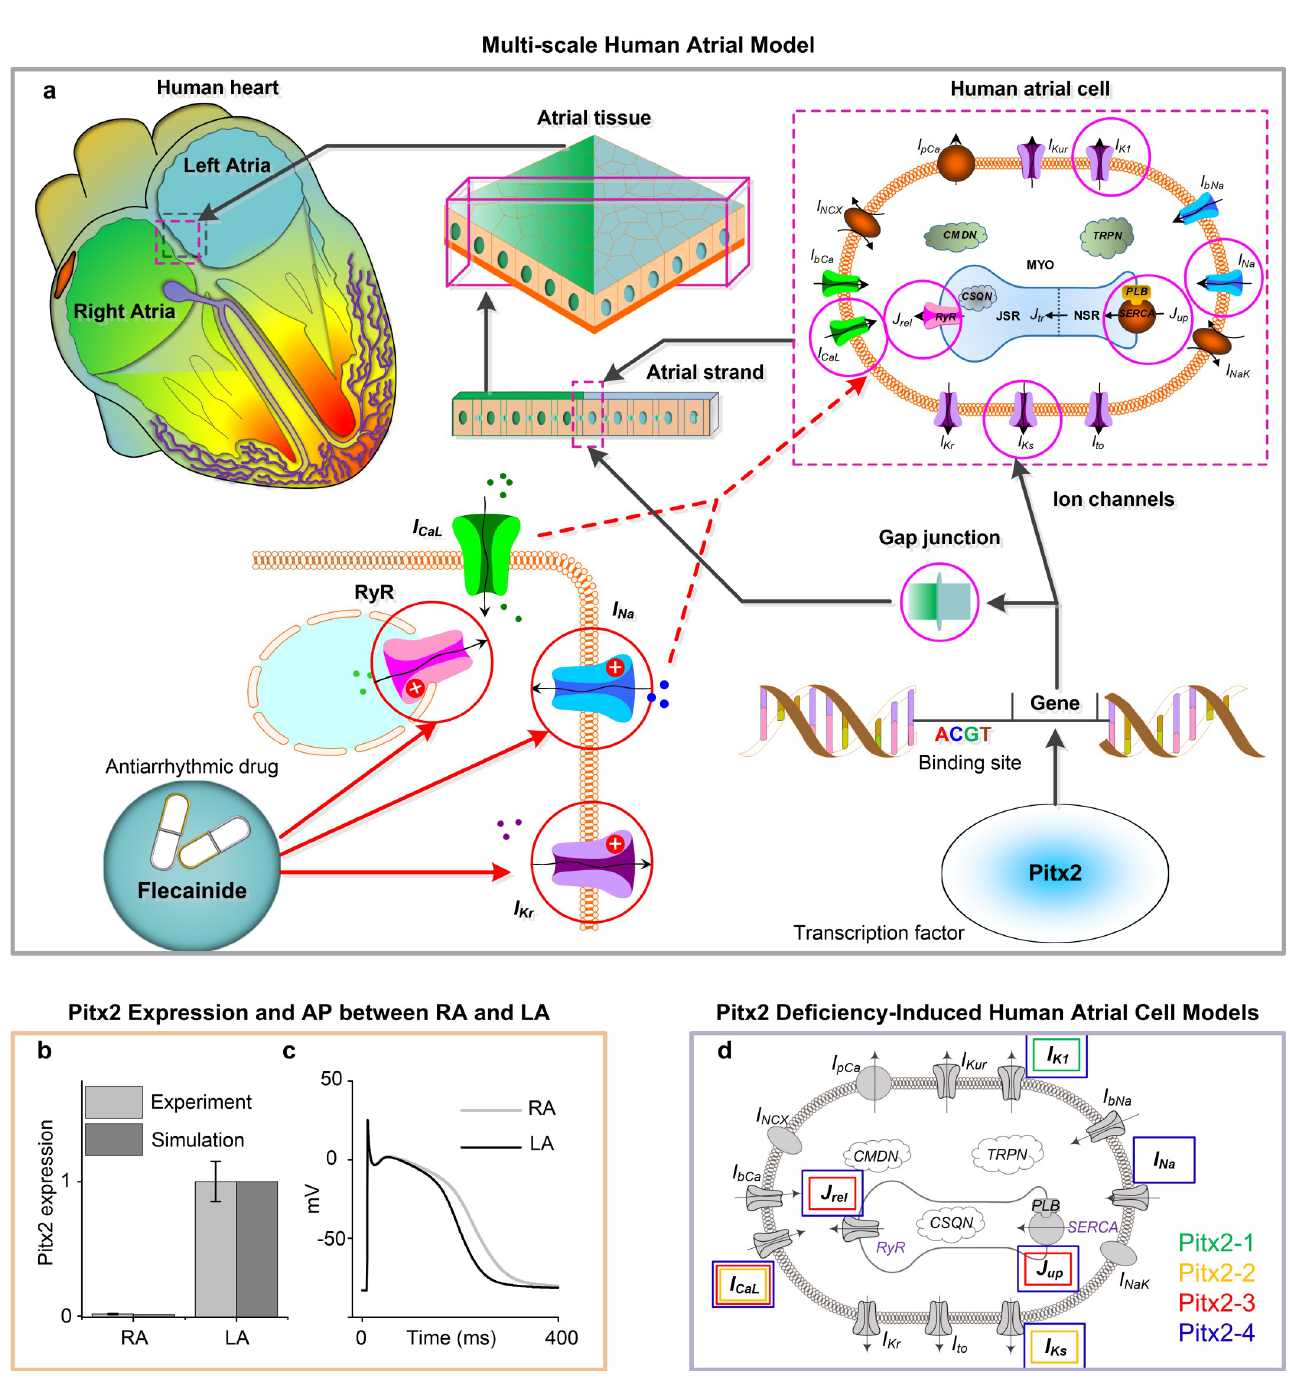
Fig 1. Multi-scale computer models to investigate the mechanism underlying Pitx2-induced AF and the effects of class Ic AAD (flecainide). a , The computer models incorporated Pitx2-induced electrical and structural remodeling, and flecainide interactions with ion channels. Remodeled targets (magenta circles) included gap junction, I K1 , I Ks , I Na , I CaL , RyR and SERCA. Drug targets of flecainide (red circles) were I Kr , I Na and RyR. Under the control condition, heterogeneity in Pitx2 expressions ( b ) and AP ( c ) between LA and RA was included in the computer models. d , Based on experimental and clinical studies up to date, four Pitx2 deficiency-induced human atrial cell models were developed: Pitx2-1 with remodeled I K1 (green), Pitx2-2 with remodelled I Ks and I CaL (magenta), Pitx2-3 with remodelled I CaL , RyR and SERCA (red) and Pitx2-4 with remodelled I K1 , I Ks , I Na , I CaL , RyR and SERCA (blue). Abbreviations: AF–atrial fibrillation; AAD–antiarrhythmic drug; LA–left atrium; RA–right atrium; AP–action potential; RyR–ryanodine receptor; SERCA–calcium transport ATPase.